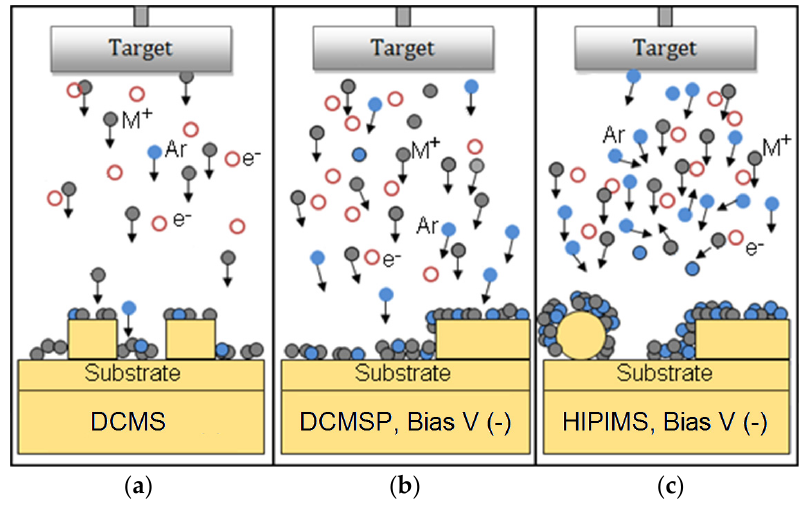
Figure 7. Schematics of the ( a ) DCMS, ( b ) DCMSP and ( c ) HIPIMS sputtering of metal ‐ ions (M + ) on 3 ‐ D